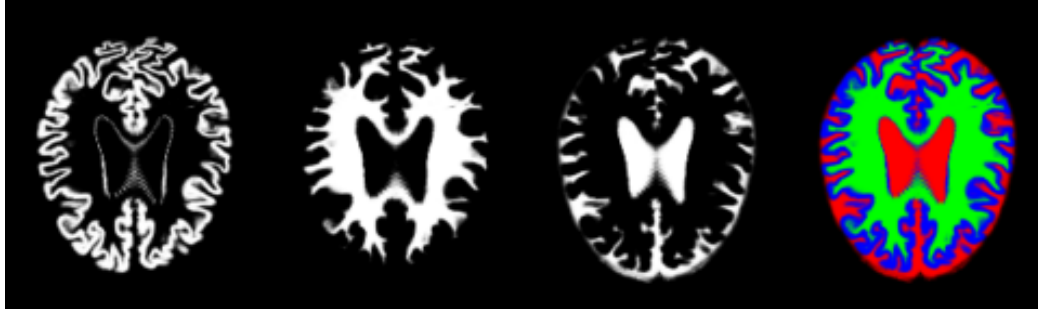
Figure 3. Volume slice from the pre-processed OASIS-1 dataset, showing tissue segmentation probabilities and its corresponding aggregate slice as an RGB image. Gray matter probabilities ( left ), white matter probabilities ( middle left ), cerebrospinal fluid ( middle right ) and aggregate ( right ) (Gray matter probabilities as blue, white matter probabilities as green, cerebrospinal fluid as